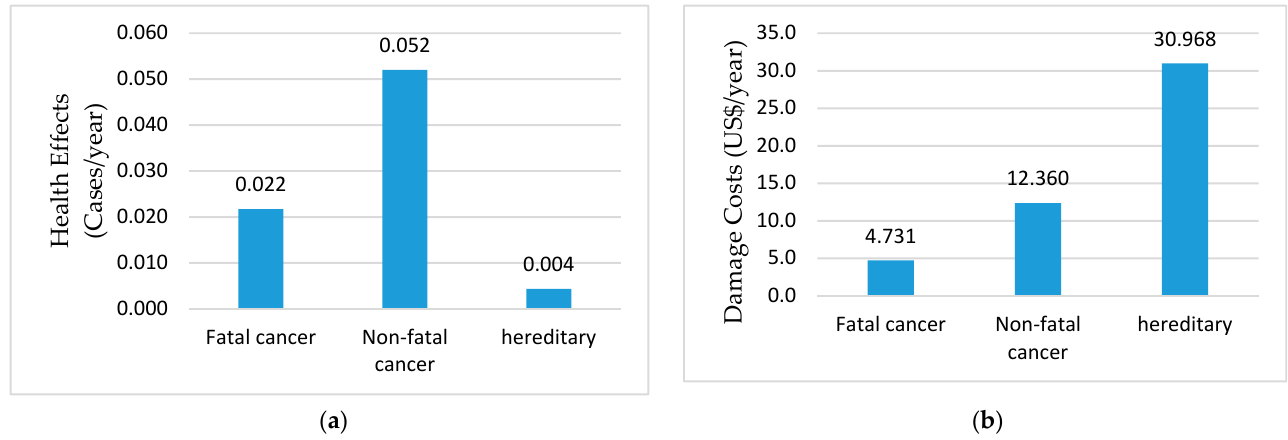
Figure 7. Health impacts and damage costs of the proposed Geregu NPP in Nigeria. ( a ) SIMPACT results showing various health effects from the released of radioactive materials during normal operation per year. ( b ) SIMPACT results showing damage cost resulting from radioactive materials released during normal operation per year.